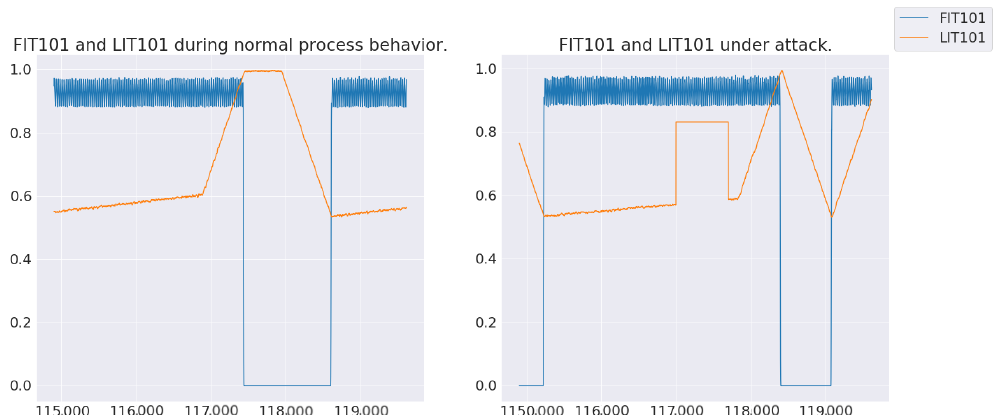
Figure 6. The relationship between Level Indicator 101 (LIT101)and Flow Indicator 101 (FIT101) under normal behavior ( left ) and under non-stealthy attack ( right